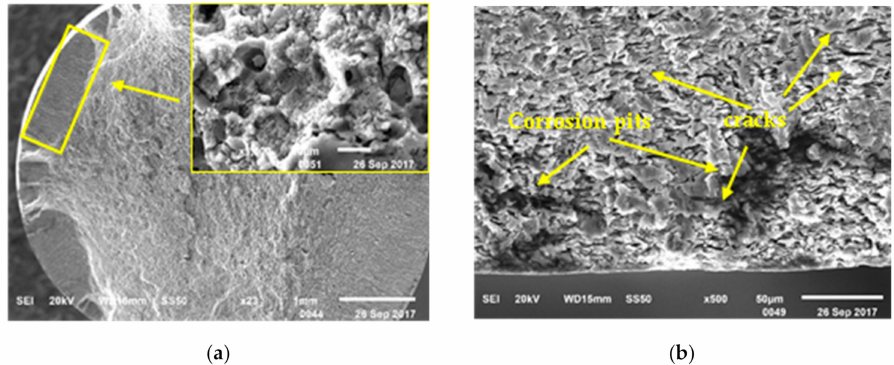
Figure 10. Fractographies of the SSRT test sample in distilled water. ( a ) Overall, ( b )